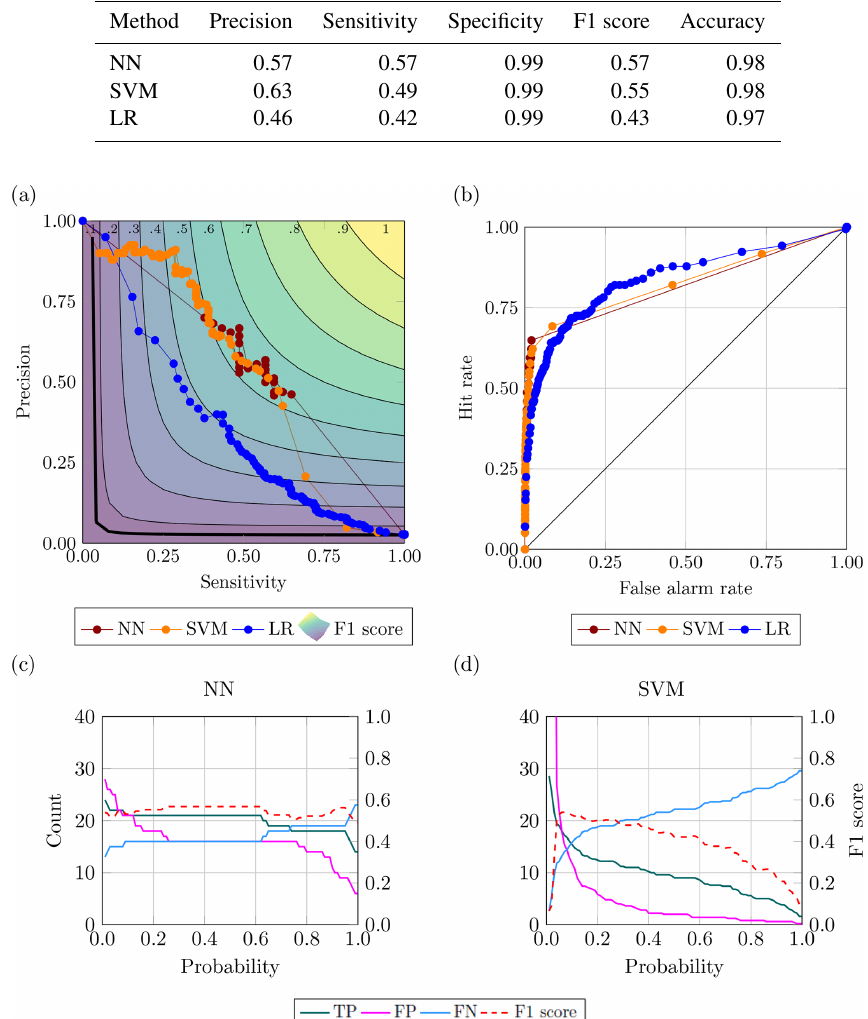
Figure 10. Best-performing configurations for the flood case: (a) PS curve; (b) ROC curve; and variation of true positive, false positive, true negative and F1 score for the range of probability (c) in NN and (d) in